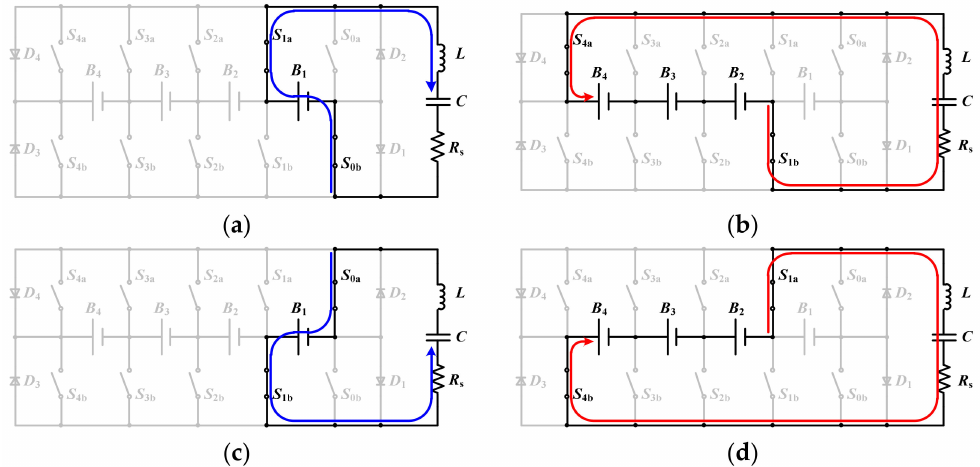
Figure 6. Switching states and steady-state’s current flow of the proposed equalizer at V B4 = V B3 = V B2 < V B1 . ( a ) Positive collect: state I. ( b ) Positive release: state II. ( c ) Negative collect: state III. ( d ) Negative release: state